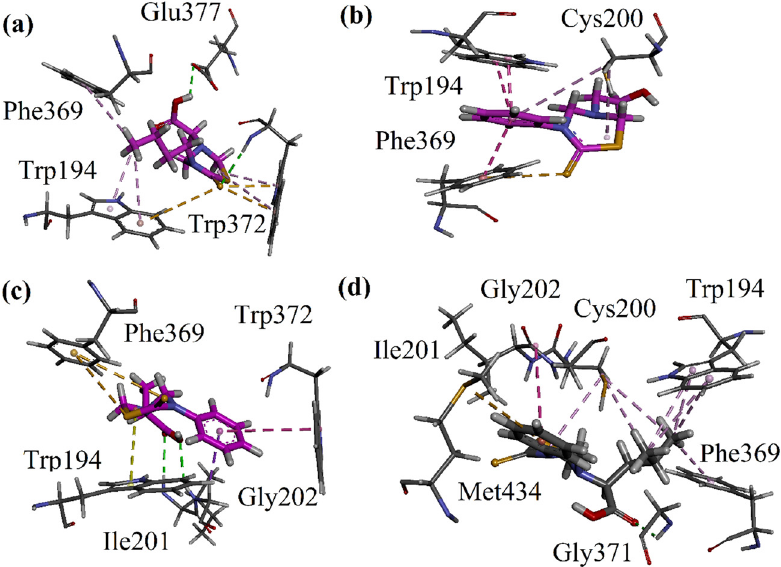
Figure 4: ( a – d ) 3 - D interaction plots of compounds 9 , 10 , 12 , and 13 modeled by using Discovery Studio Visualizer in the binding site of iNOS ( PDB ID = 4NOS ) .